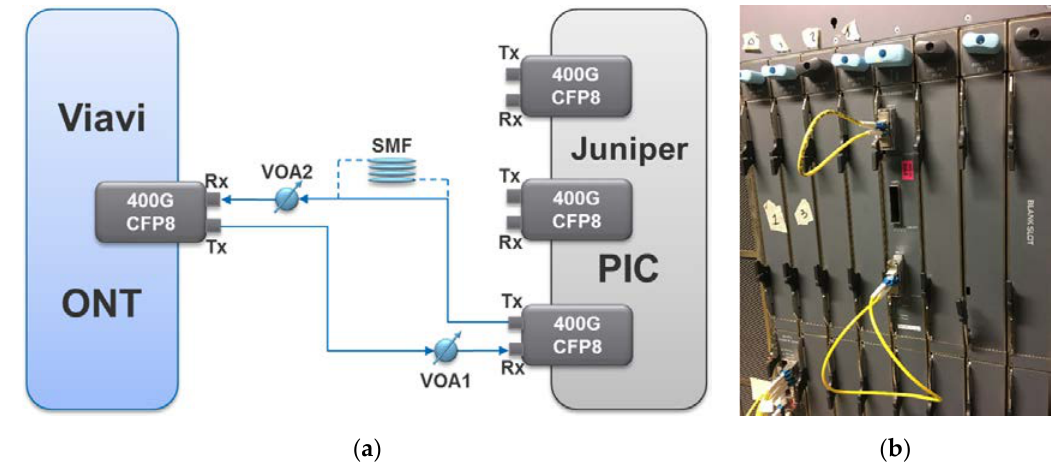
Figure 6. ( a ) Experimental demonstration of the interoperation of CFP8-LR8 modules; ( b ) two CFP8-LR8 modules in Juniper’s PIC and PTX5000 chassis.